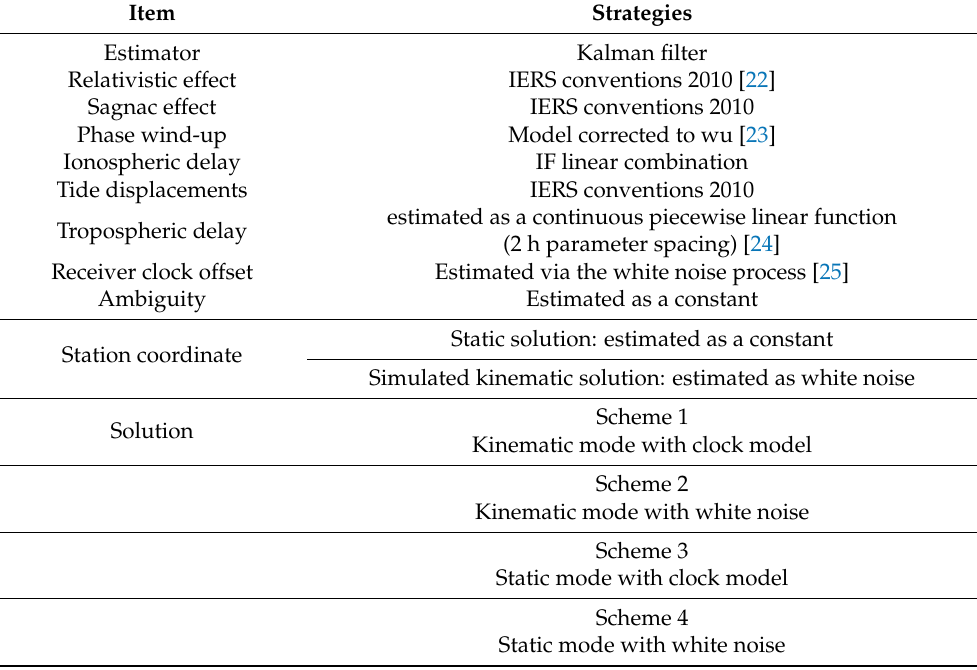
Table 2. PPP processing